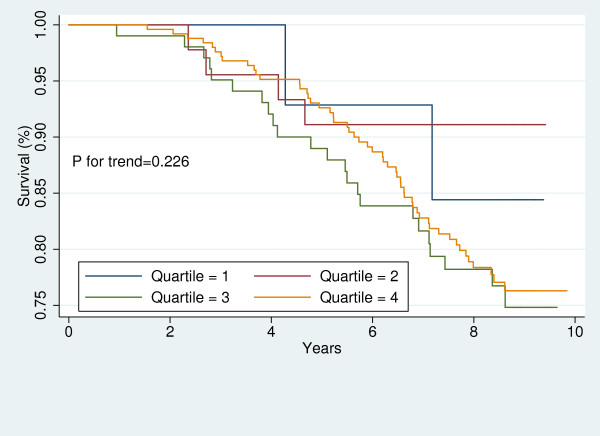
Kaplan-Meier curves for all-cause mortality across LAP quartiles in women with global CVD risk 20% or more.